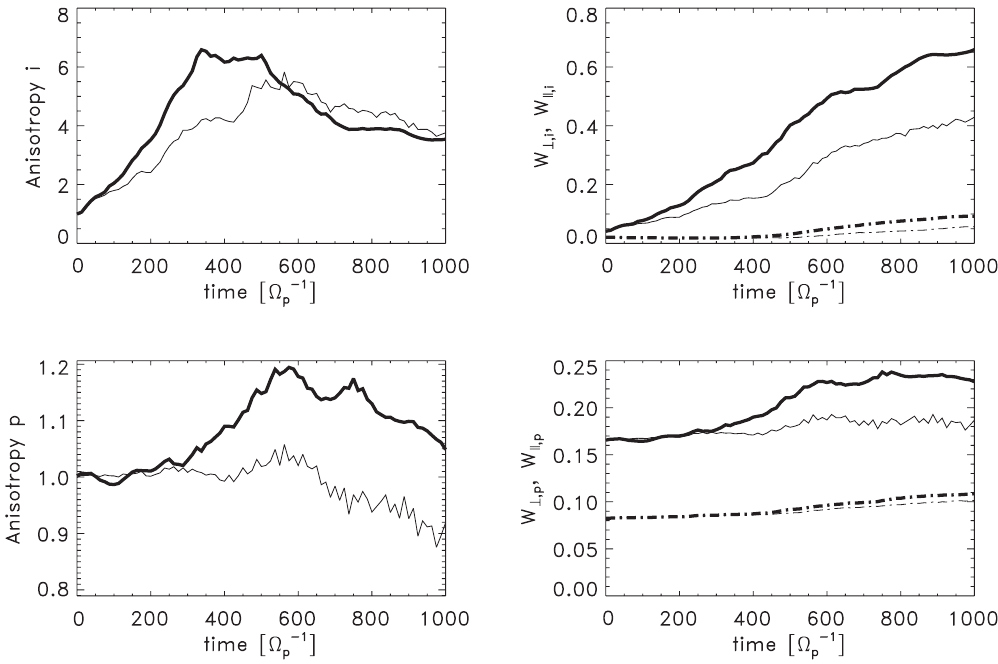
Fig. 2. The left panels show the evolution of the anisotropy of He ++ ions (top panel) and protons (lower panel). The right panels show the corresponding evolution of the perpendicular (solid) and parallel (dot-dashes) kinetic energies of He ++ ions and protons for the 2-D hybrid model of plasma heating with Alfv´enic fluctuations spectrum. The thick curves are for the inhomogeneous plasma, Eq. (12), and the thin curves are for homogeneous background